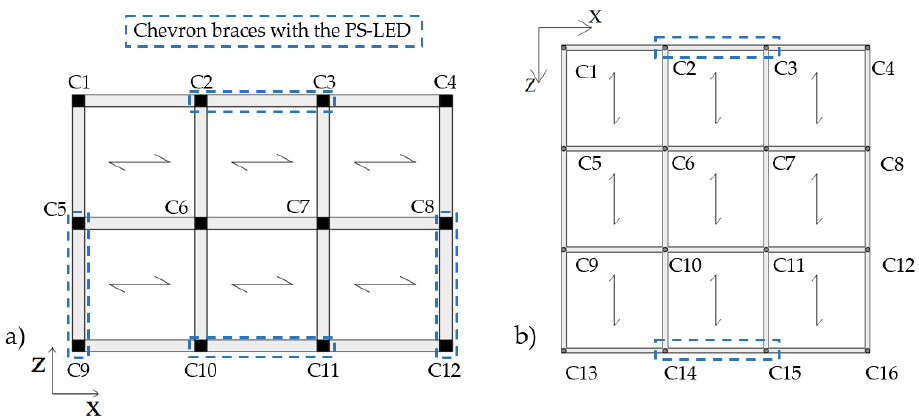
Figure 12. Plan layout of the Chevron braces equipped with the PS-LED: ( a ) RC structure, and ( b ) steel MRF.